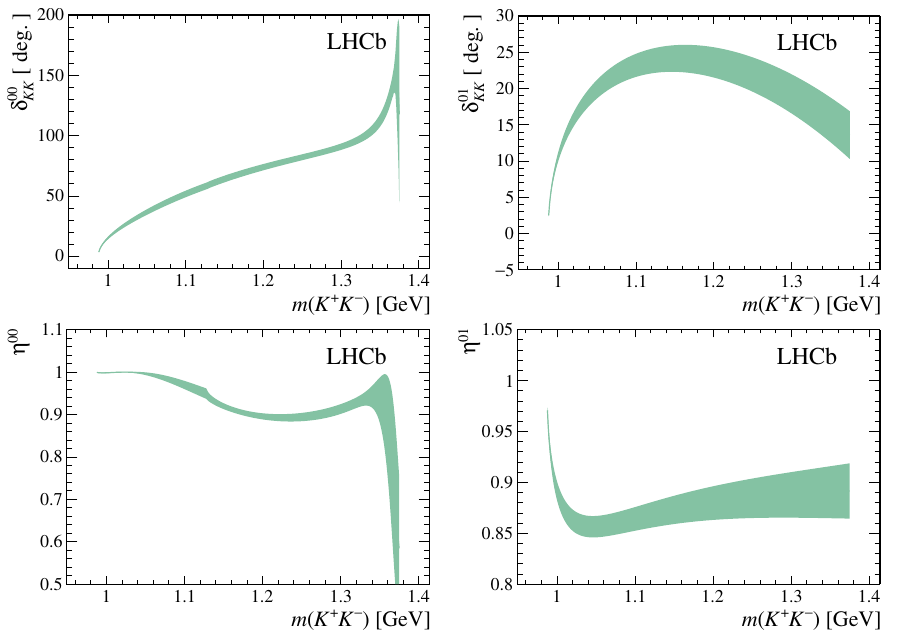
Figure 14 . (top) Phase-shifts (cid:14) 0 I and (bottom) inelasticities (cid:17) 0 I as a function of the K + K (cid:0) K + K (cid:0) invariant mass, for both isospin